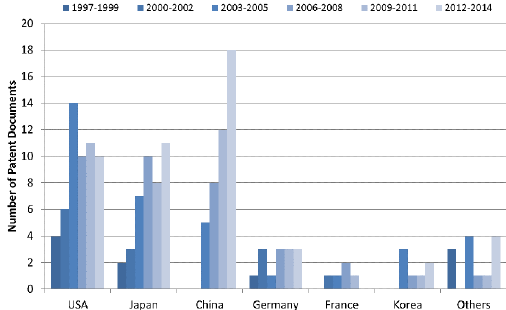
Figure 3. Number of patents regarding amorphous alloys processed by thermal spraying processes, by priority countries. Source: Derwent Innovations